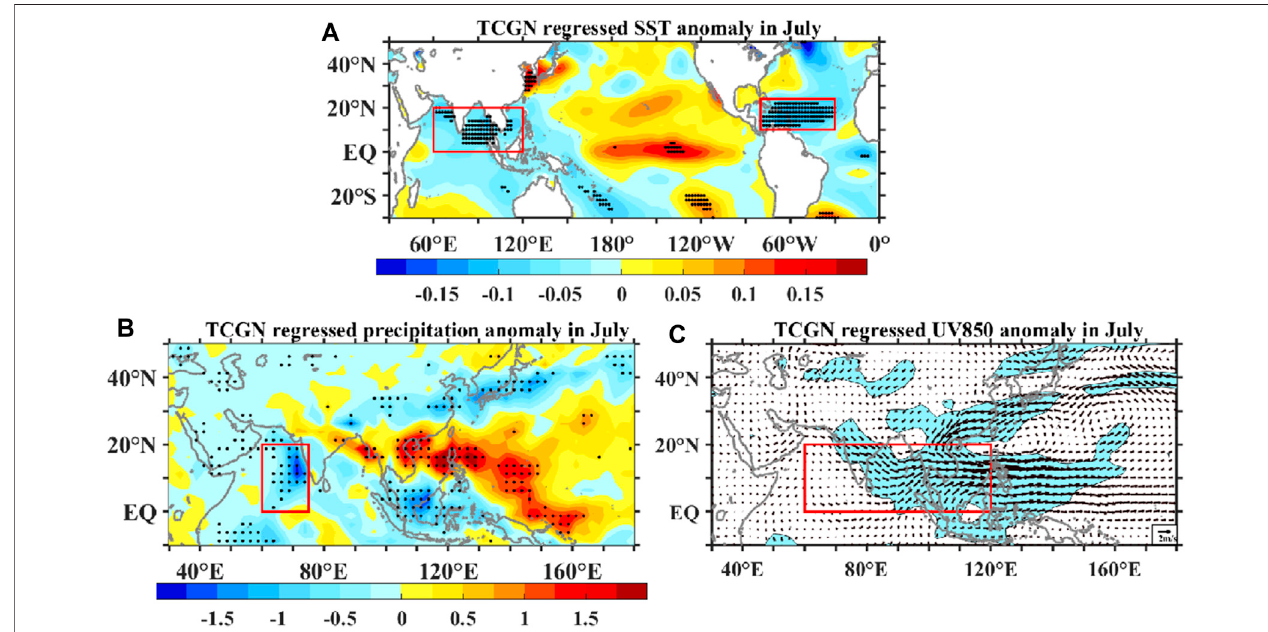
FIGURE 5 | Regression patterns of the July. (A) SST anomaly (units: K), (B) precipitation anomaly (units: mm/day), and (C) UV850 (units: m/s) upon the standardized July TCGN during 1980 – 2020. Dotted (a, b) and shaded (c) areas indicate statistical signi fi cance at the 95% level, as estimated by a Student ’ s t -test. The regions marked by the red rectangle are used to de fi ne SSTI-NIO (0 ° – 20 ° N, 60 ° – 120 ° E), SSTI-ATL (10 ° – 24 ° N, 30 ° – 80 ° W), PRECI (0 ° – 20 ° N, 60 ° – 75 ° E), and U850I (0 ° – 20 ° N, 60 ° – 120 ° E).